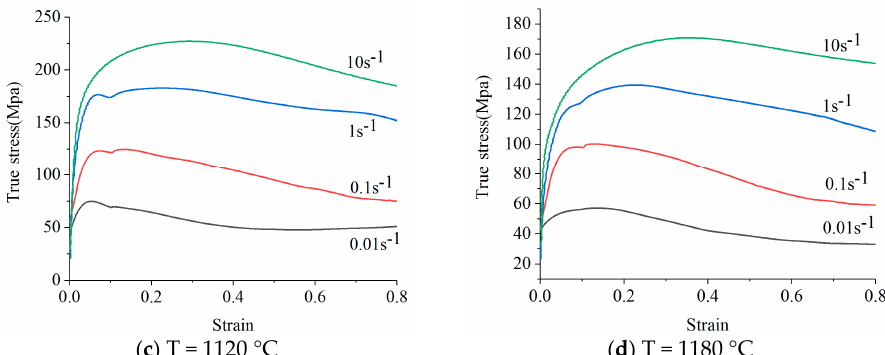
Figure 2. Stress-strain curves of 21-4N heat-resistant steel at different strains with temperature of ( a ) 1000 °C; ( b ) 1060 °C; ( c ) 1120 °C; ( d ) 1180 °C [33].